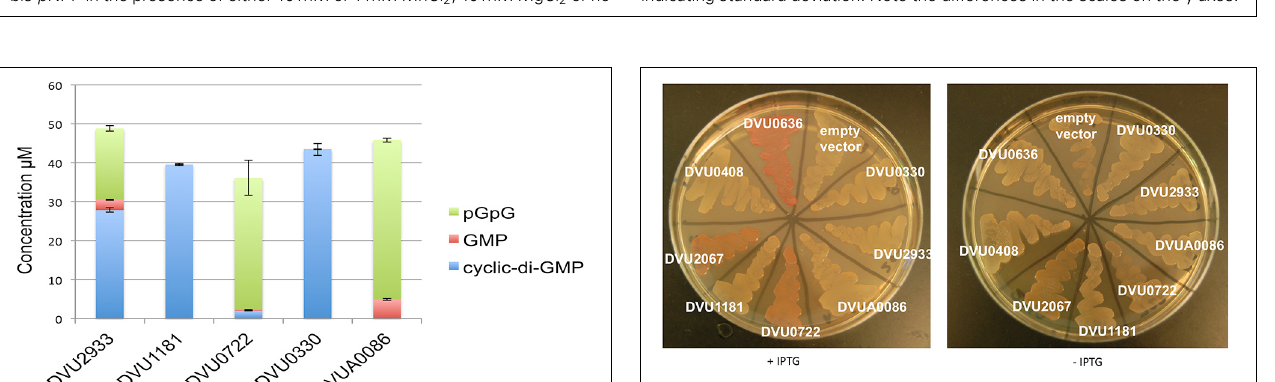
FIGURE 5 | Isolated HD-GYP domains have PDE activity with bis- p NPP. Isolated HD domains for the RRs were mixed with the synthetic substrate bis- p NPP in the presence of either 10mM or 1mM MnCl 2 , 10mM MgCl 2 or no